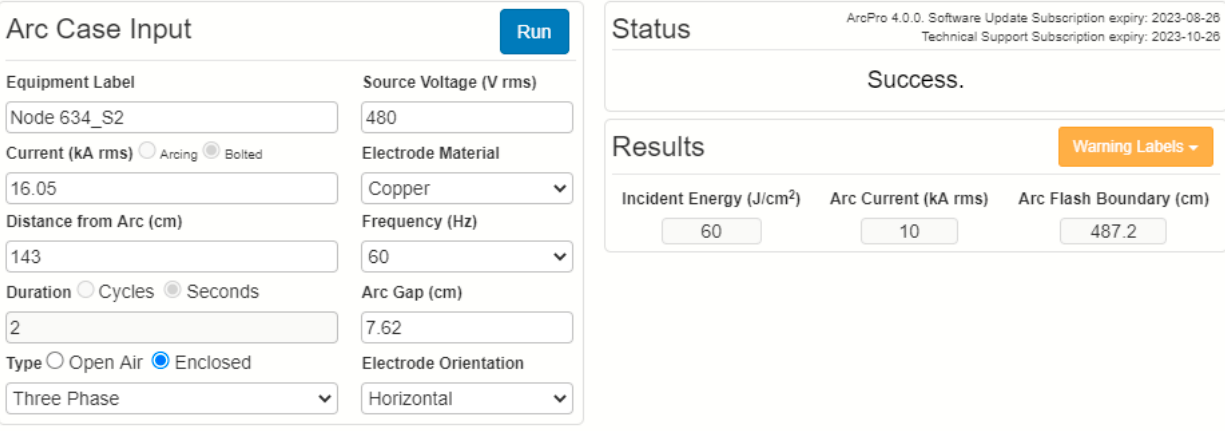
Figure 14. ArcPro simulation results—Case study 5. Table 11. ArcPro simulation results summary—Case study